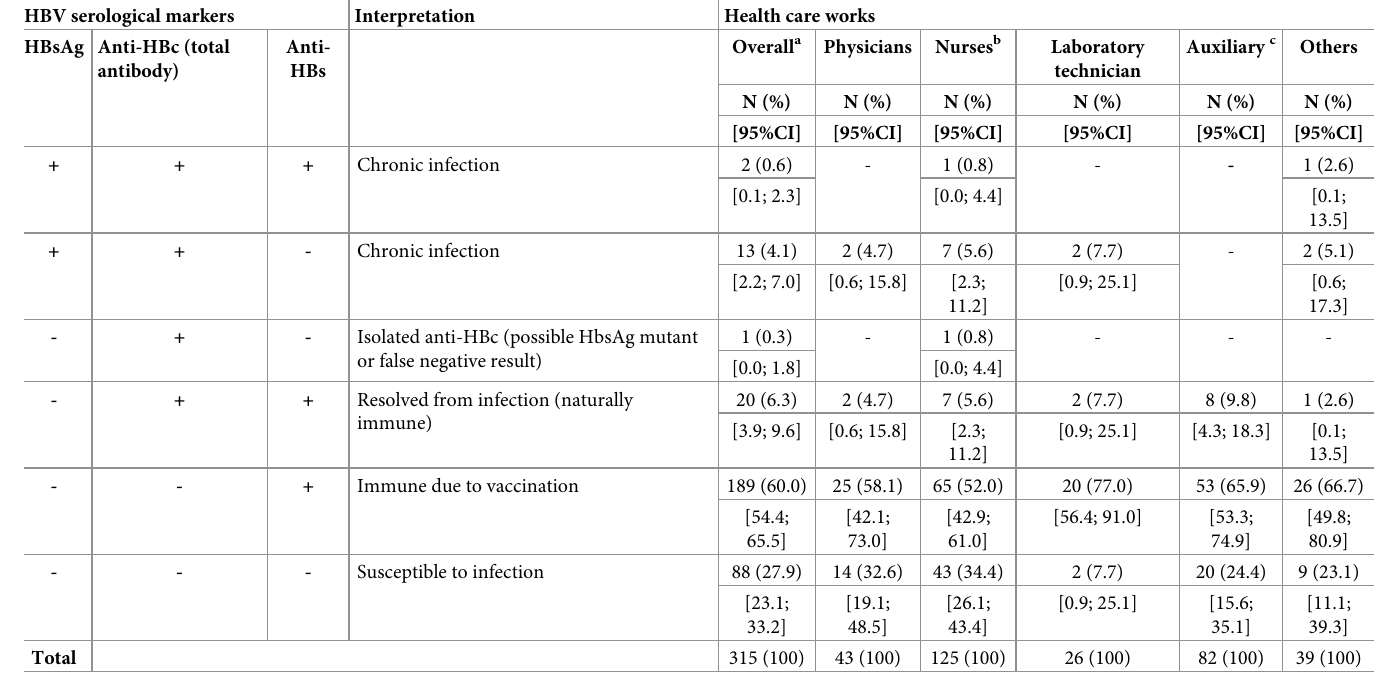
Table 3. Serological profile of HBV infection among healthcare workers.